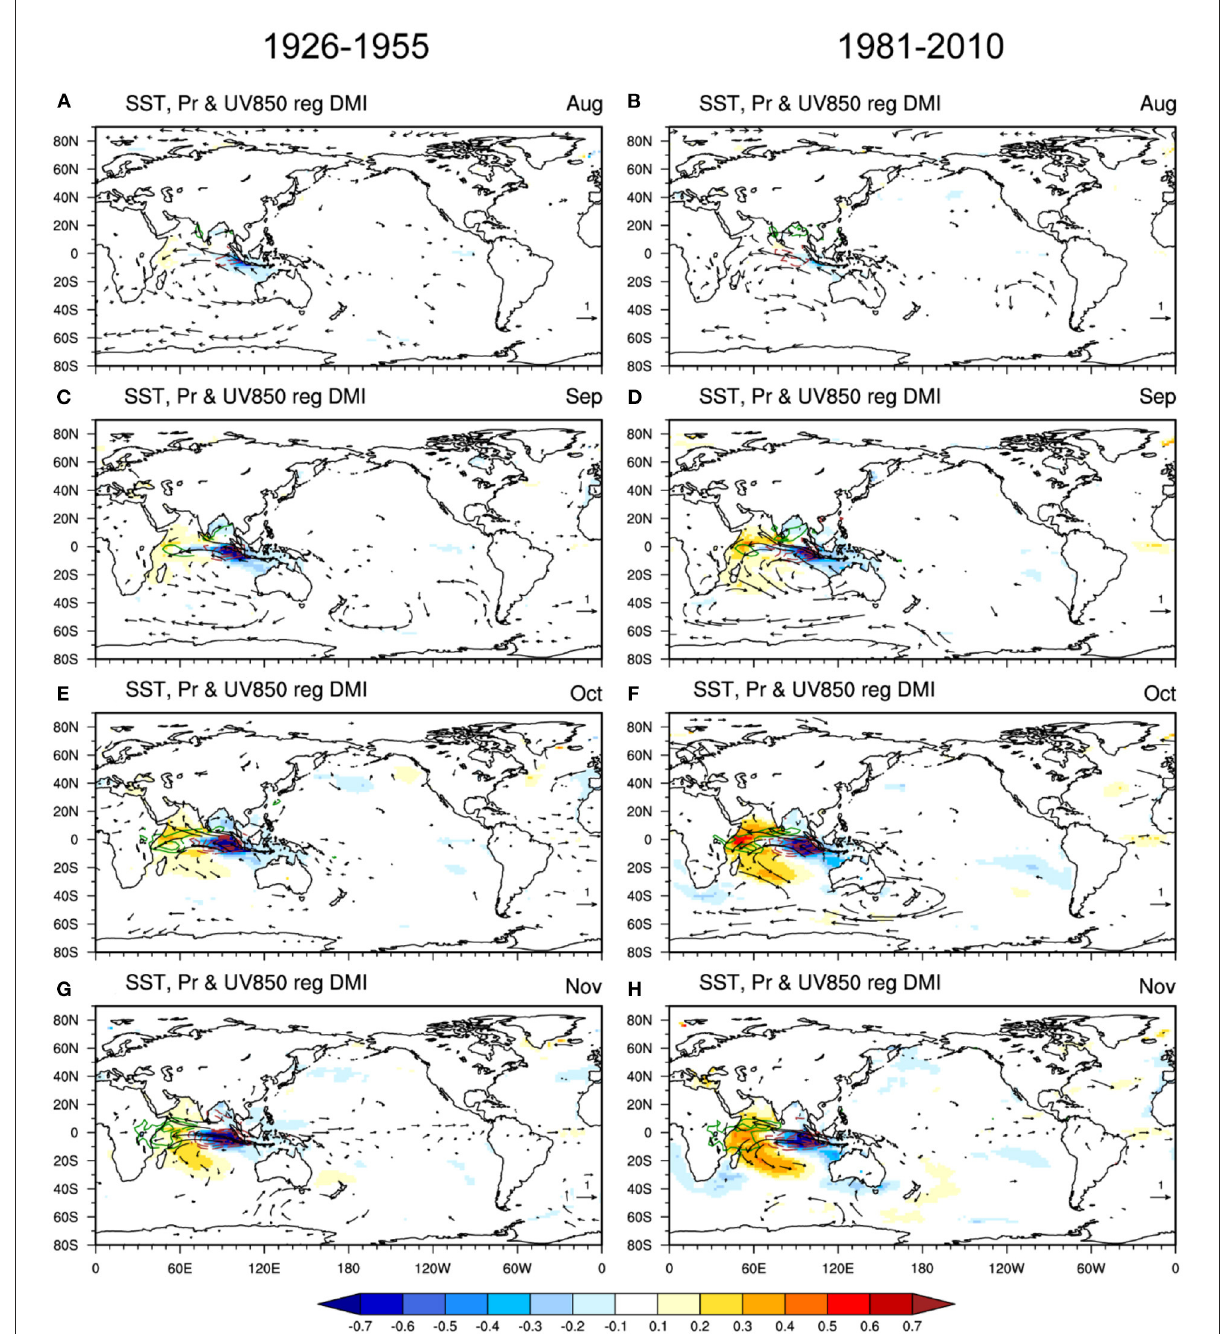
FIGURE7 Left: Regression of monthly SSTA (shading, unit: ◦ C), precipitation (contour, unit: mm/day), and 850-hPa wind anomalies (vector, unit: m/s) onto the standardized SON-mean DMI index from the ensemble spread in the period 1926–1955: (A) August, (C) September, (E) October, and (G) November. Only values reaching the 5% significance level are shown. Right: (B, D, F, H) as in (A, C, E, G) , but for the regression in the period 1981–2010. For the regression analysis, all 25 members with the ensemble mean removed are connected to obtain a sample size as large as